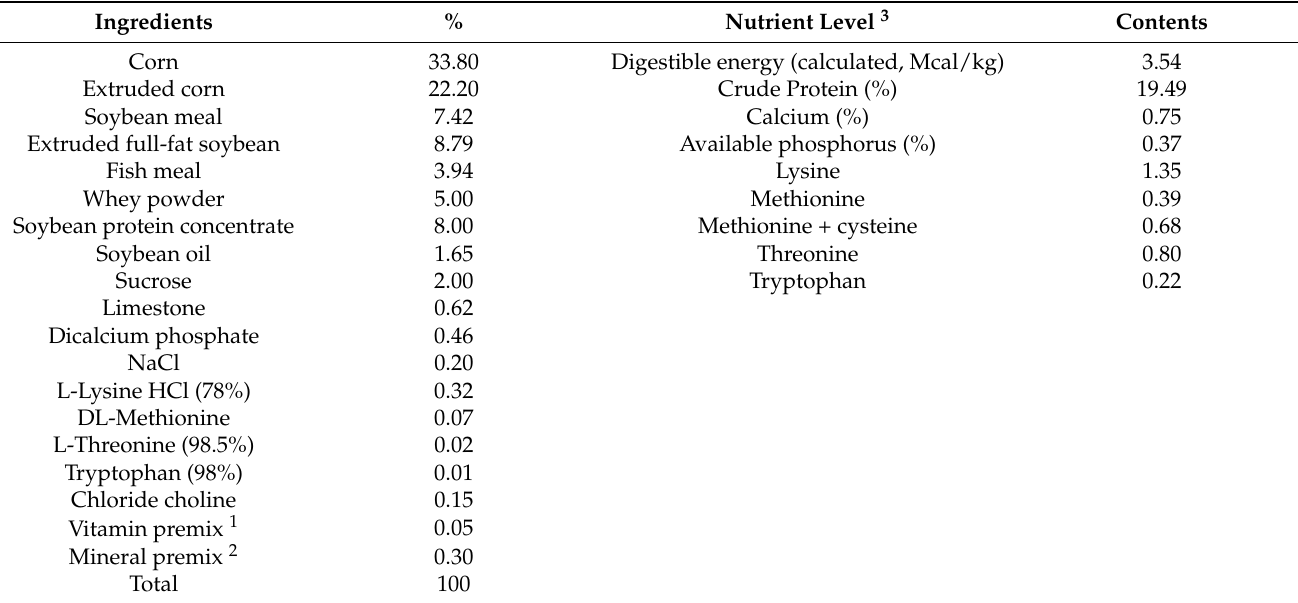
Table 1. Composition and nutrient level of basal